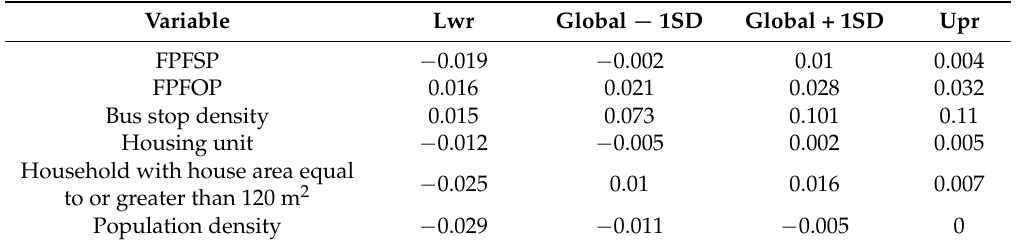
Table 5. Results of geographical variability testing of local coefficients using Chi-Square